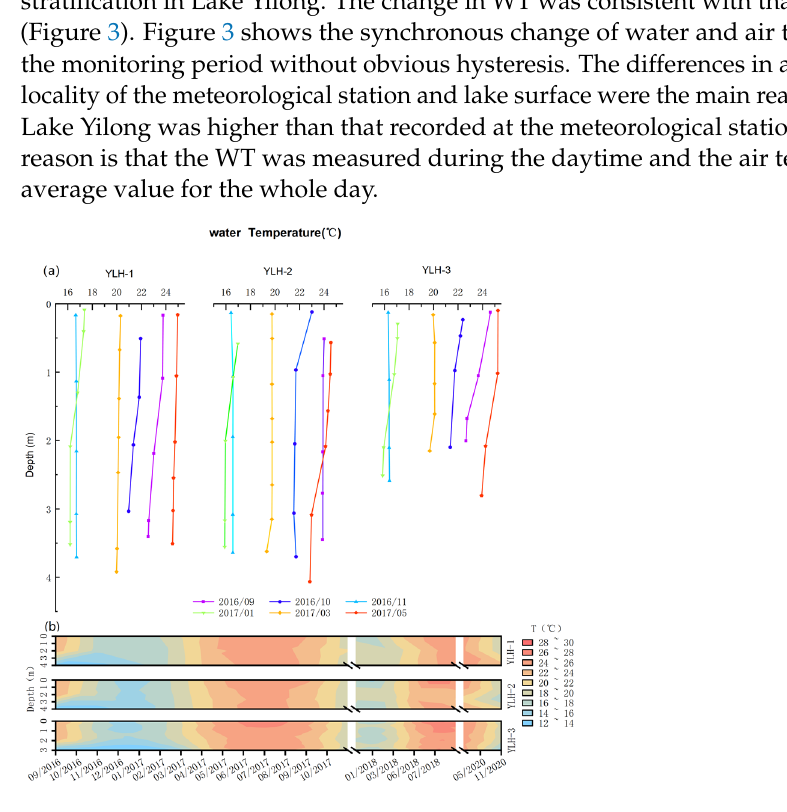
Figure 2. Seasonal and interannual variations in water temperature in lake Yilong. ( a ) Seasonal variations in water temperature; ( b ) Interannual variations in water temperature.